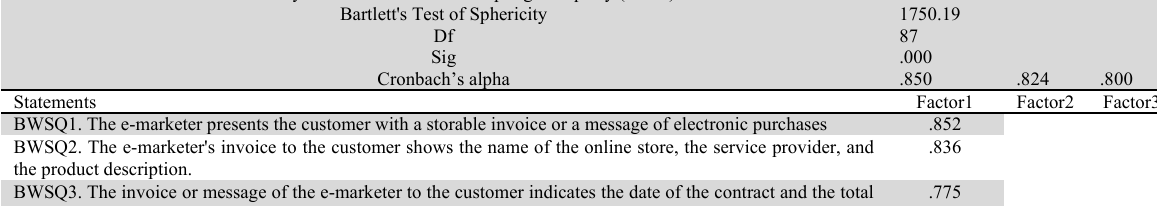
Kaiser normalization test and principal component analysis Kaiser-Meyer-Olkin Measure of Sampling Adequacy